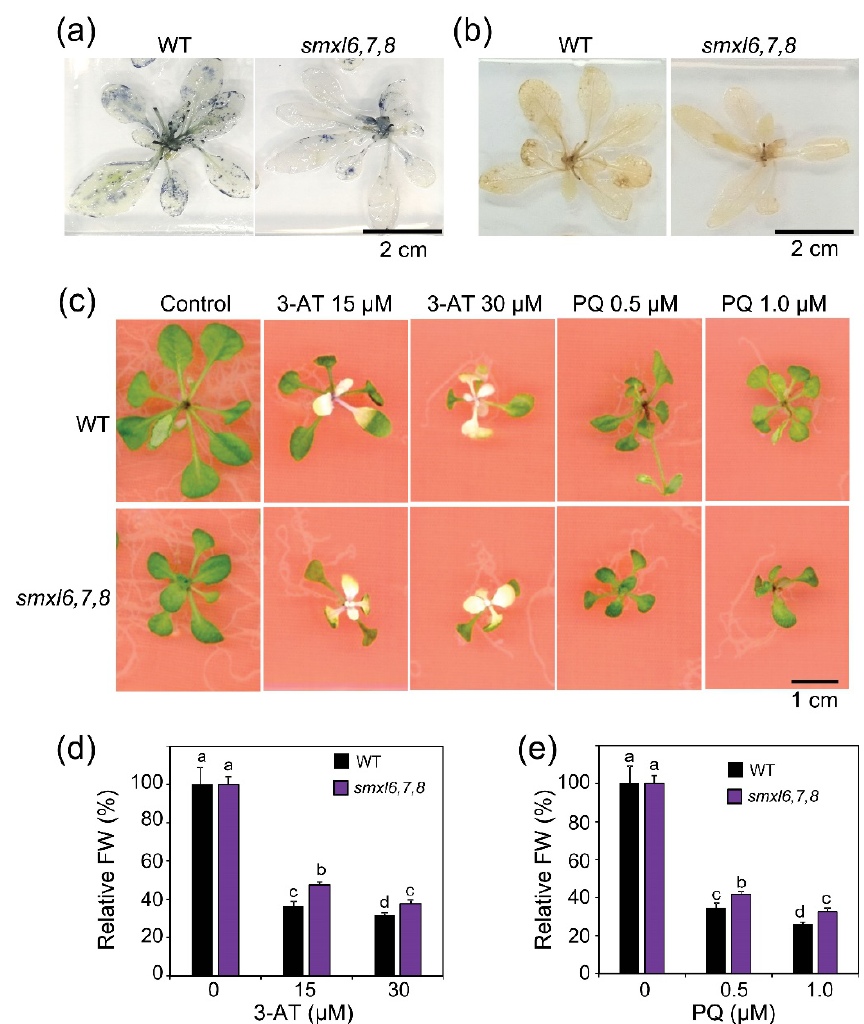
Figure 5. Detoxification capacity of reactive oxygen species in smxl6 , 7 , 8 mutant and wild-type (WT) plants. ( a , b ) Histochemical analyses of O 2 . – accumulation ( a ) and H 2 O 2 accumulation ( b ) through nitro blue tetrazolium ( a ) and 3,3 ′ -diaminobenzidine ( b ) stainings of rosette leaves of 28-day-old smxl6 , 7 , 8 mutant and WT plants. ( c ) Growth inhibition assays of the two genotypes using 3-amino-1,2,4-triazole (3-AT) and paraquat (PQ). Representative pictures of 21-day-old plants are shown. ( d , e ) Relative fresh weights (FWs) of 21-day-old smxl6 , 7 , 8 mutant and WT plants grown on medium supplied with different concentrations of 3-AT ( d ) or PQ ( e ). Data show means and standard errors ( n = 10 plants/genotype). Letters above the error bars show significant differences in all combinations (Tukey’s honest significant difference test; p < 0.05).